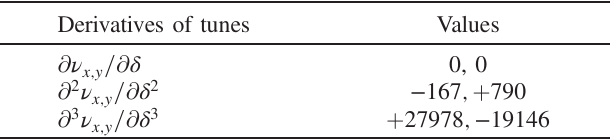
TABLE IV. The chromatic tune shifts in the collider that contain two interaction